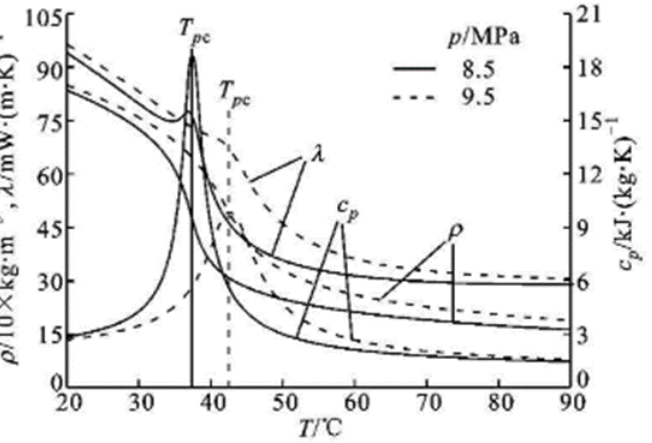
Figure 2. CO 2 physical parameters change with temperature and pressure.